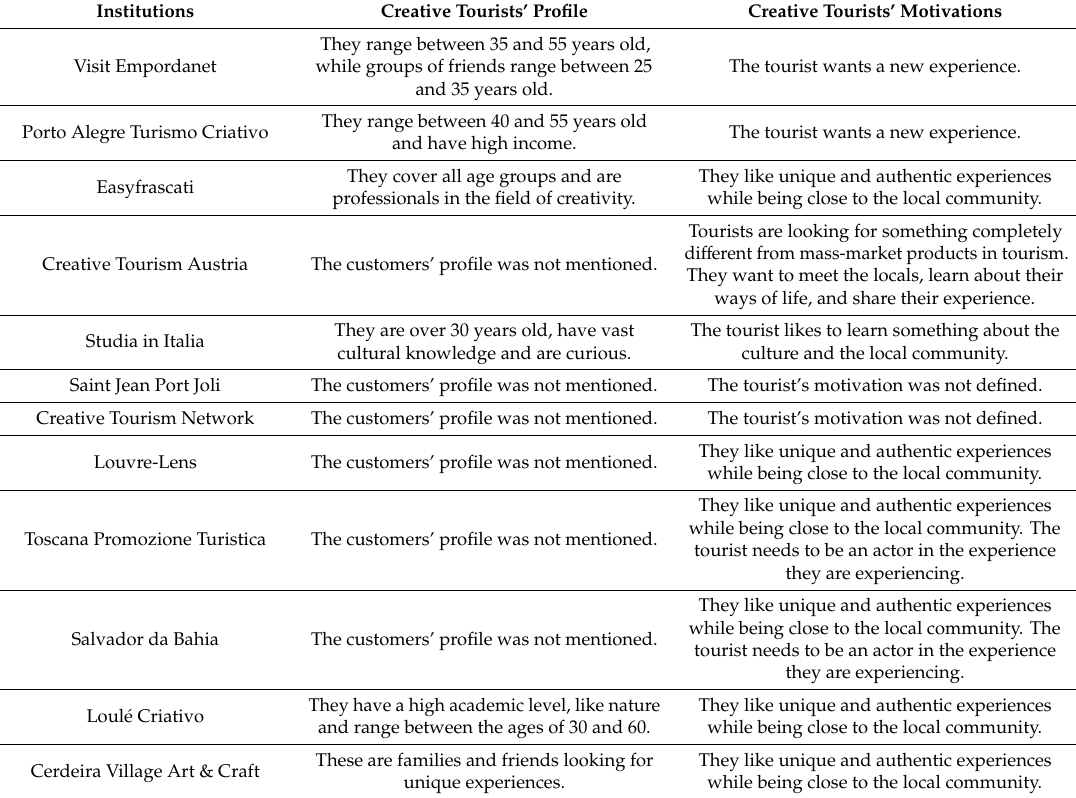
Table 3. Views of the institutional managers interviewed on their creative tourists’ profile and their